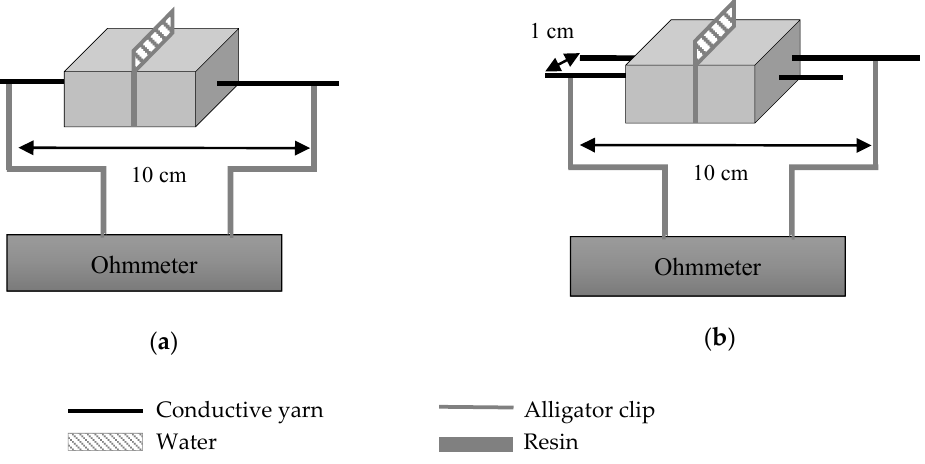
Figure 4. Principle of water detection by absorption ( a ) and by a short circuit ( b ) with the electrically conductive yarns incorporated into a resin plate, and the same schemes—but without resin—for the study of detection principles on conductive yarns only.